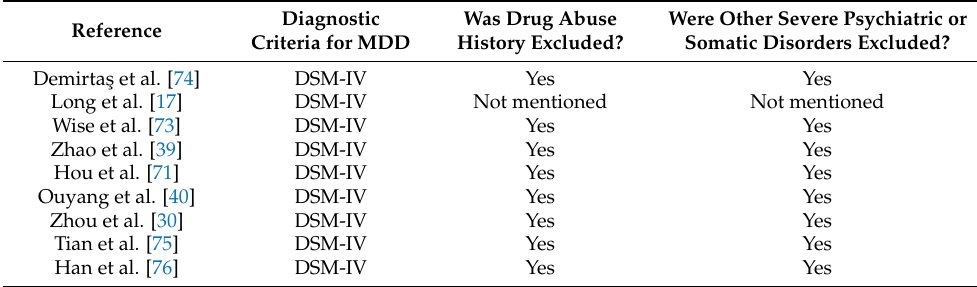
Table A2. Additional information about the studies on major depressive disorder (MDD) as men- tioned in this manuscript. DSM, Diagnostic and Statistical Manual of Mental Disorders.